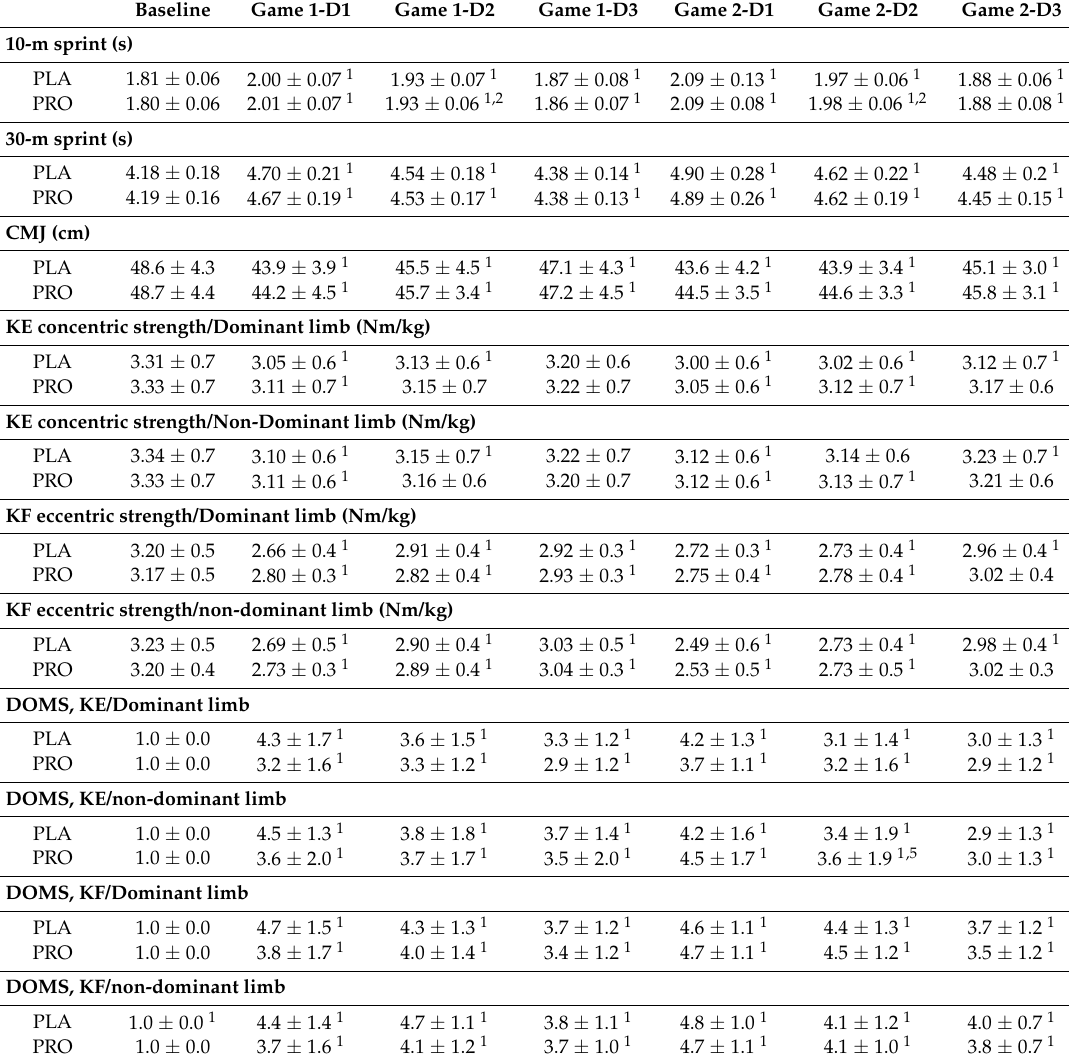
Table 5. Changes in performance measures in response to protein and placebo